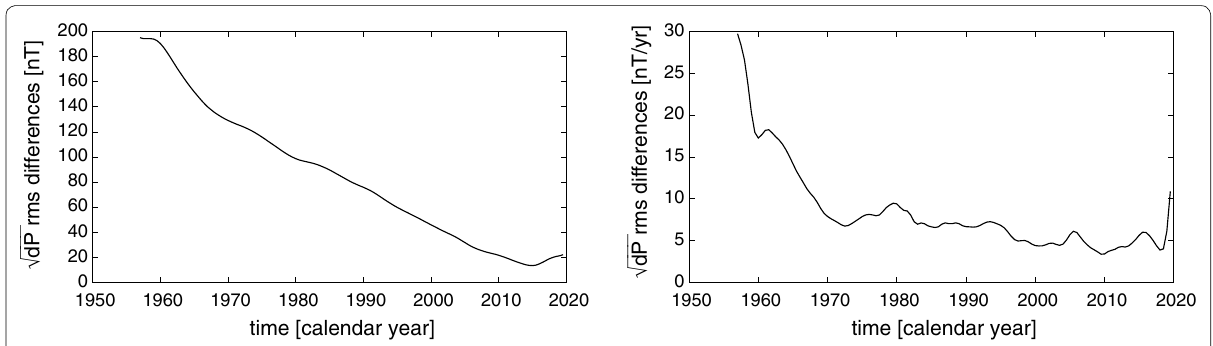
Fig. 2 Temporal evolution of the rms difference ( √ dP ) of the main field (left) and secular variation (right) between models 1 and